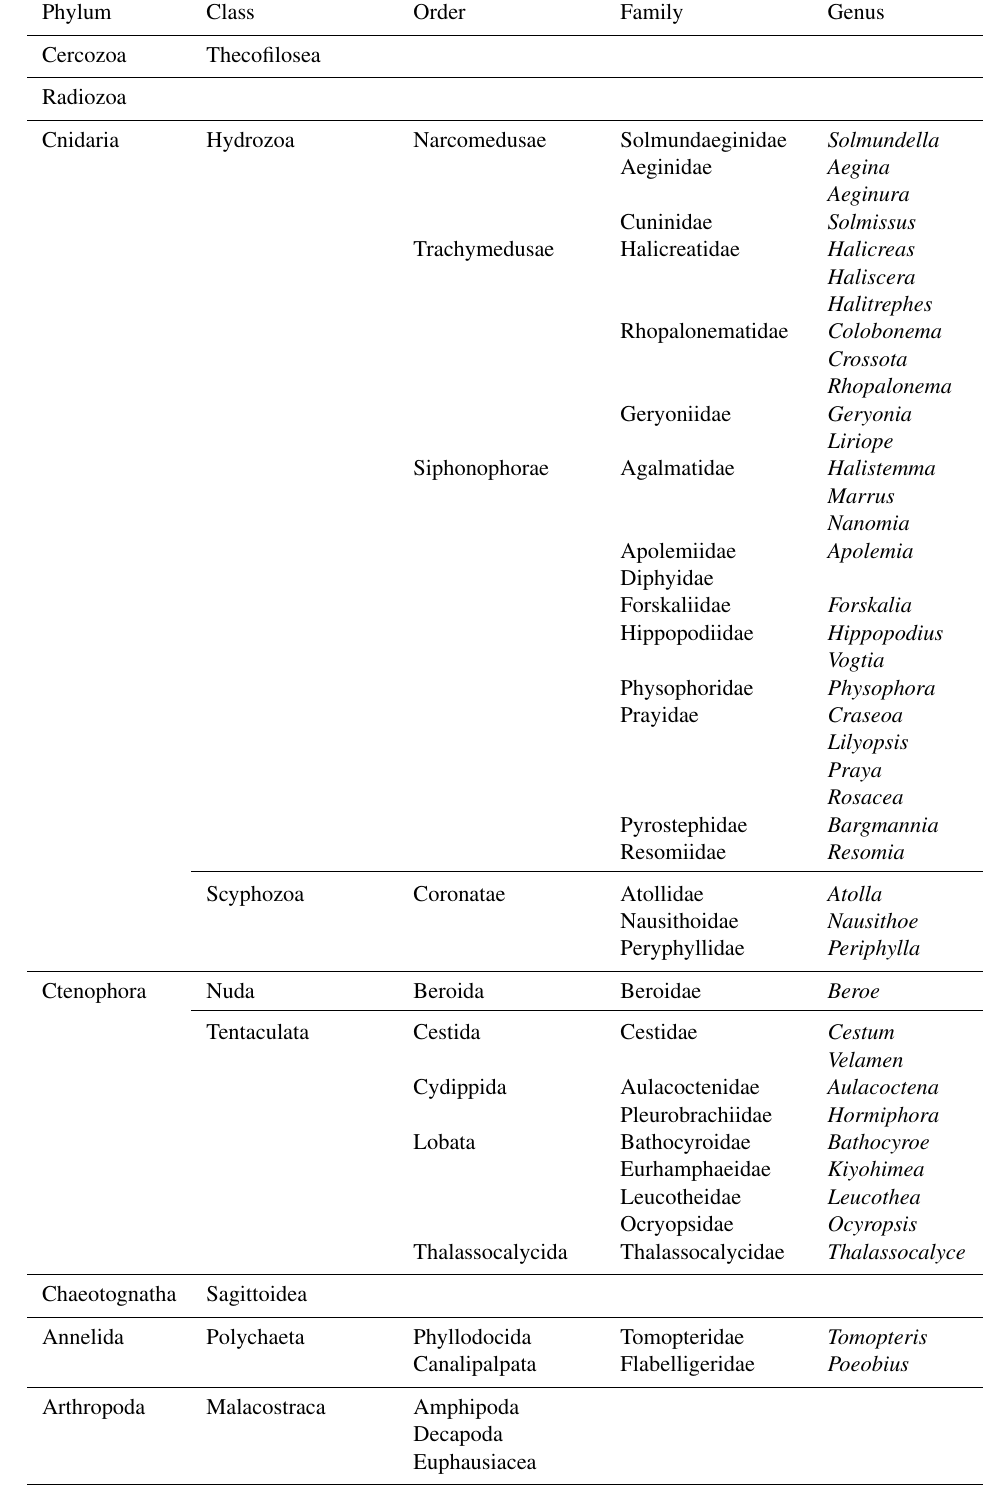
Table 1. Taxonomic groups which were encountered during pelagic video transects with PELAGIOS in the eastern tropical